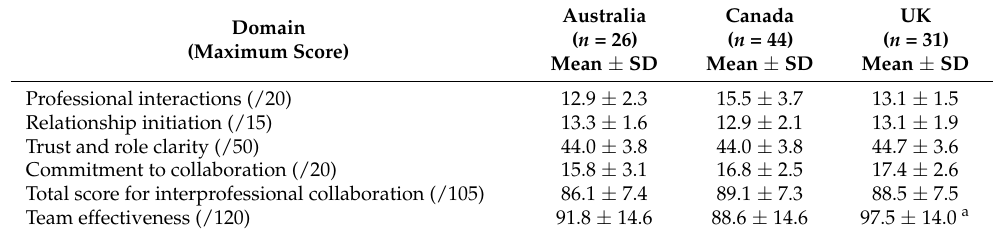
Table 2. General practice pharmacists’ scores for the